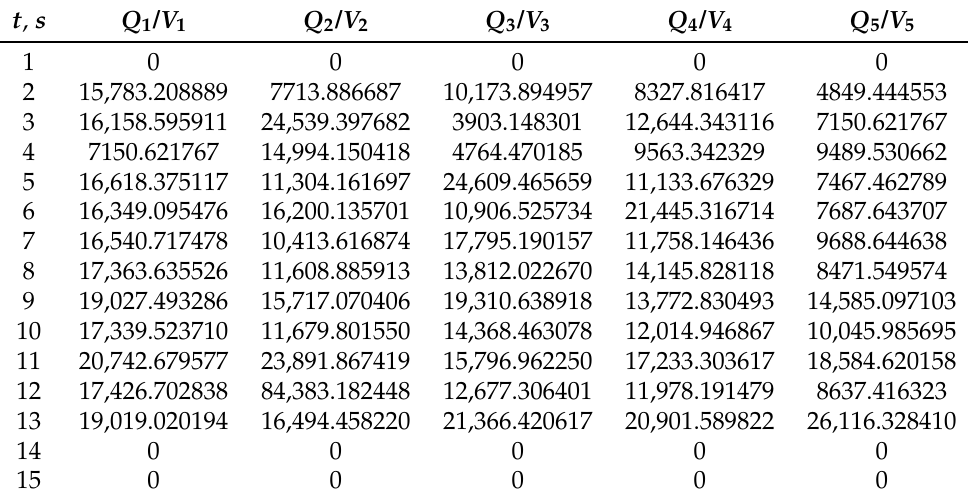
Table 4. Results of ratio